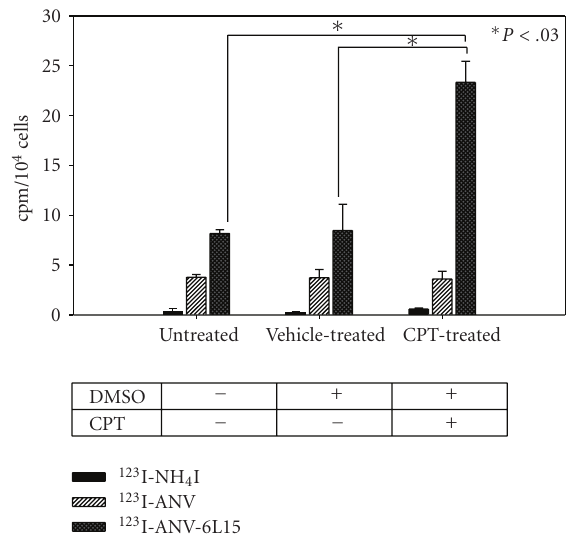
Figure 4: Binding of 123 I-ANV and 123 I-ANV-6L15 to apoptotic Jurkat T-cells. Jurkat T-cells were either left untreated or treated with camptothecin (CPT, 8 μ M) and/or vehicle (5 μ L